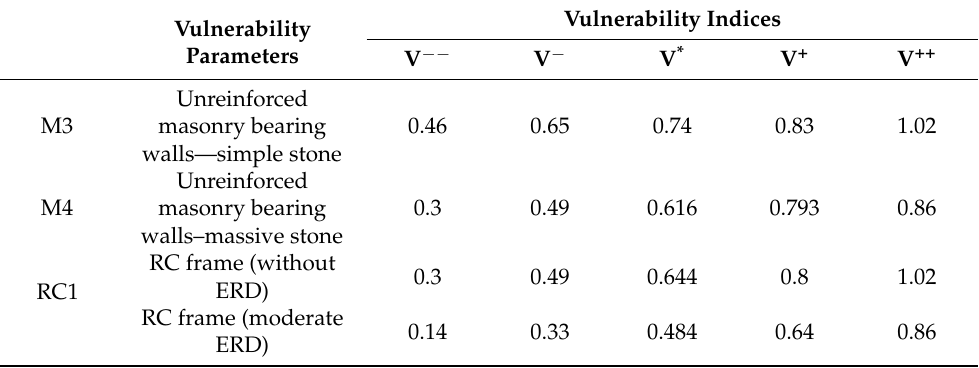
Table 2. Vulnerability indices for different building typologies. Reprinted with permission from